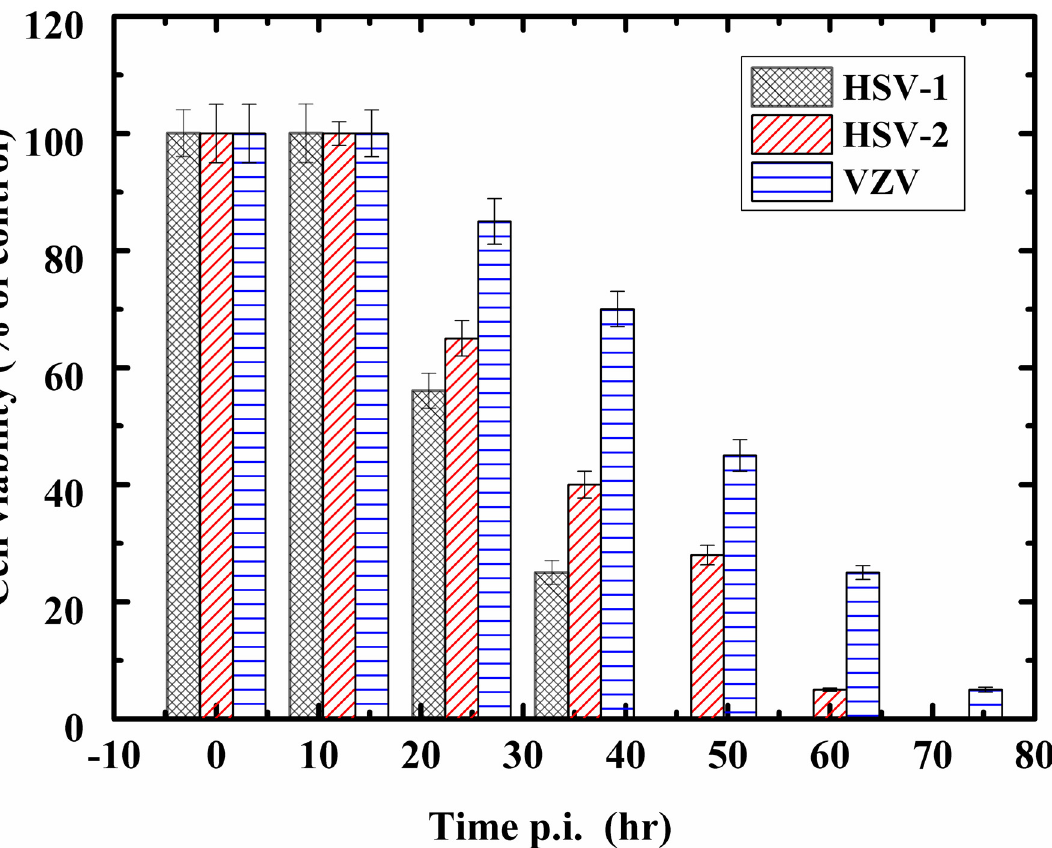
Fig 2. Effect of infection with herpes viruses on cell viability. The effect of infection with the different herpes viruses on cell viability. Vero cell monolayers were infected with 1 m.o.i. of either HSV-1, HSV-2, or VZV. Viability of the infected cells was evaluated at various times post infection (p.i.) by MTT test. Data are mean ± SD (n =